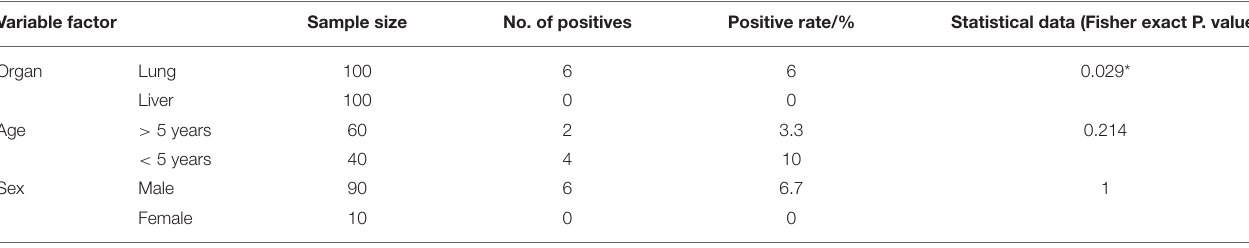
TABLE 2 | Summarizes the data of the possible associations between the occurrence of hydatid cysts in camels and the potential explanatory individual variable factors of these detected cysts. Variable factor